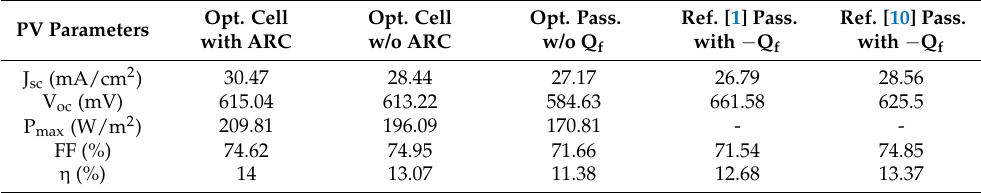
Table 3. PV characteristics of different u-CIGS models.